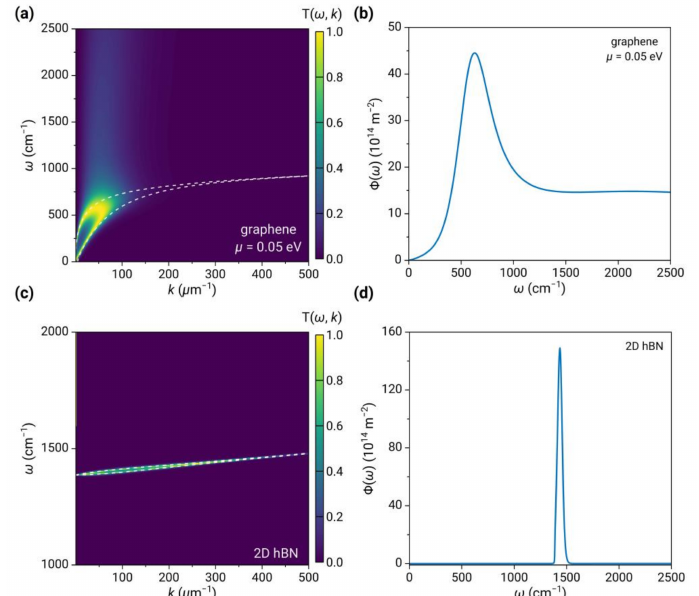
Figure 2. ( a , c ) The near-field radiative energy transmission coefficient T ( ω , k ; d ) and ( b , d ) energy transfer function Φ ( ω ) for two graphene sheets (top panels) and two 2D hBN sheets (top panels). The temperatures are 290 K and 300 K, the distance is 10 nm, and the chemical potential of graphene is 0.05 eV. The white dashed curves are dispersion